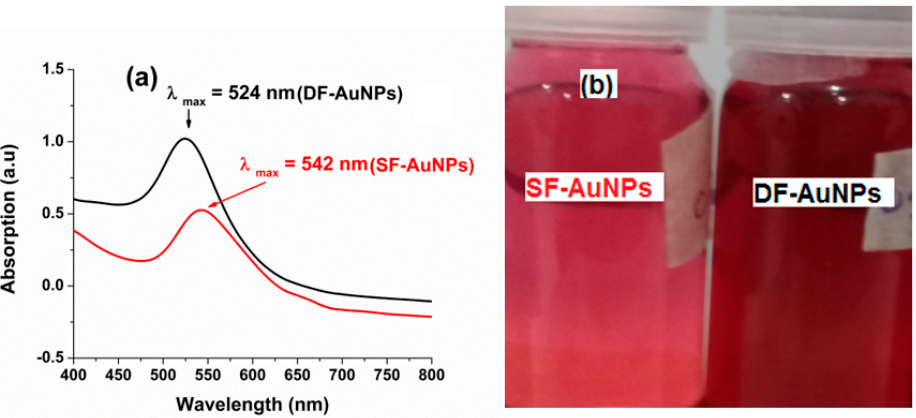
Figure 2. ( a ) UV-Vis absorption spectra of SF − AuNPs and DF − AuNPs ; ( b ) Photos of SF − AuNPs and DF − AuNPs